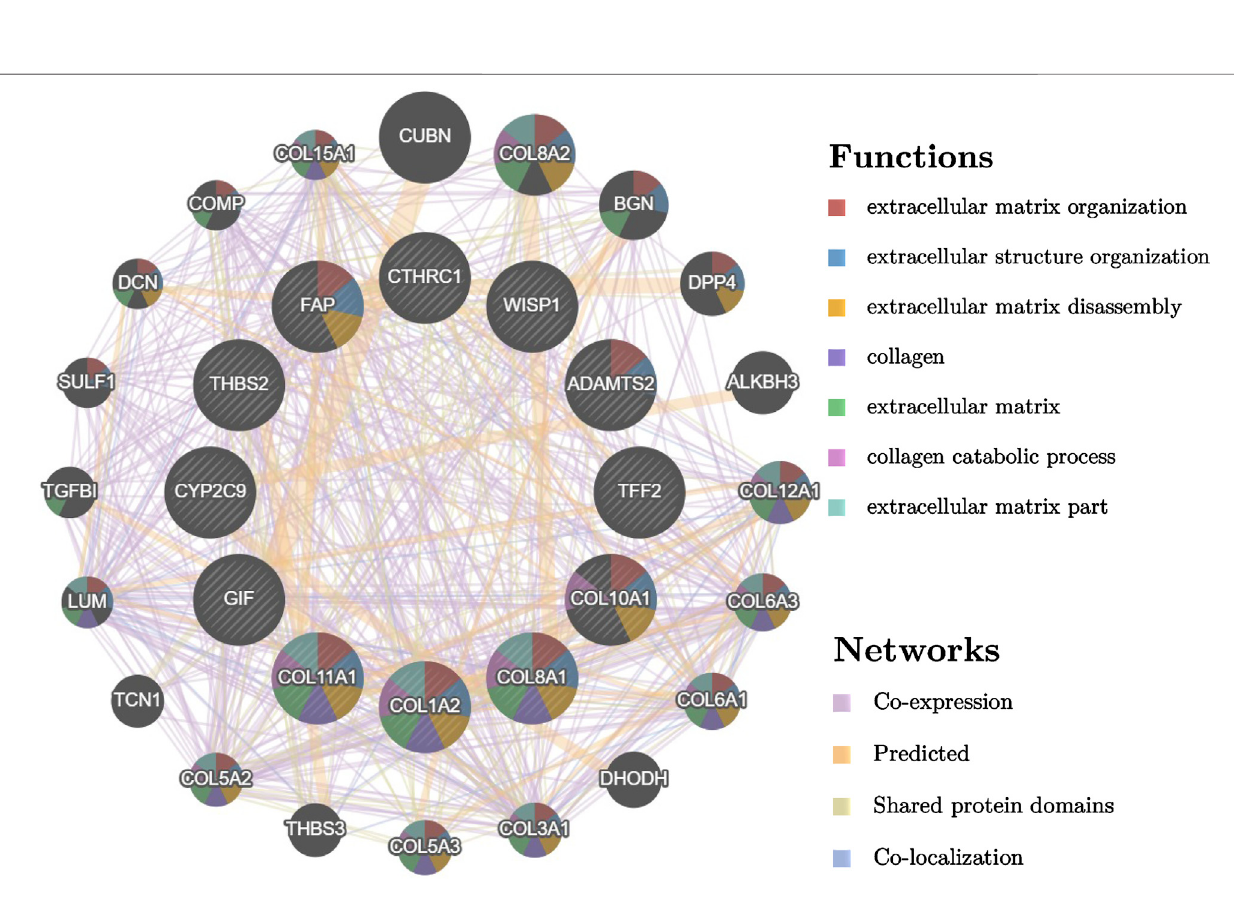
Frontiers in Genetics |